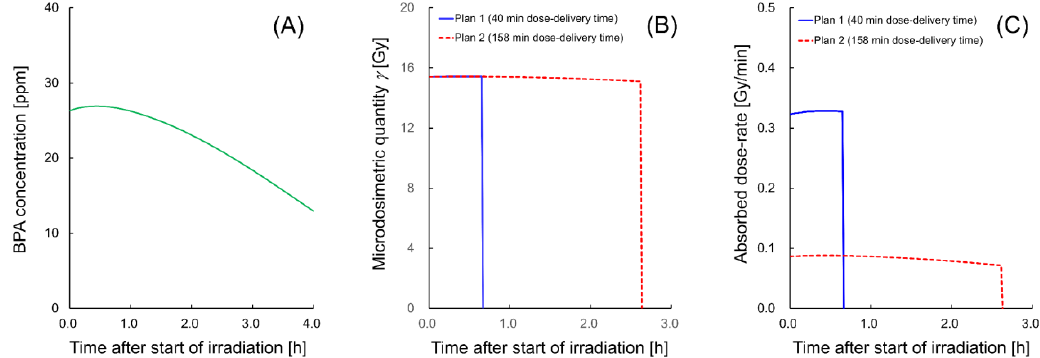
Figure 6. Timelines of the ( A ) 10 B concentration, ( B ) microdosimetric quantity and ( C ) absorbed dose rate after the start of irradiation. These example irradiation conditions exemplify the impact of 10 B concentration dynamics during irradiation (2 h after BPA injection [71]) on malignant melanoma. With reference to the literature, i.e., an experimental protocol [71] and a clinical report [72], we set out two irradiation regimens, one with a 40 min dose-delivery time and the other with a 158 min dose-delivery time, to deliver 13.86 Gy as a total absorbed dose (which is calculated from the RBE-Gy reported in the literature [71]).